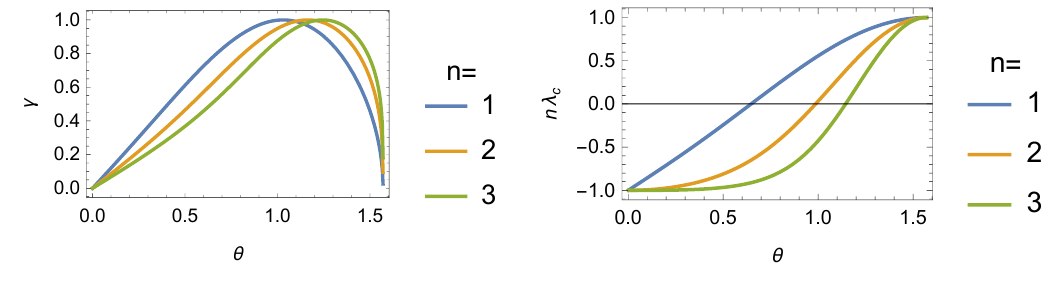
Figure 4 . γ and nλ c as functions of θ for n = 1 , 2 , 3